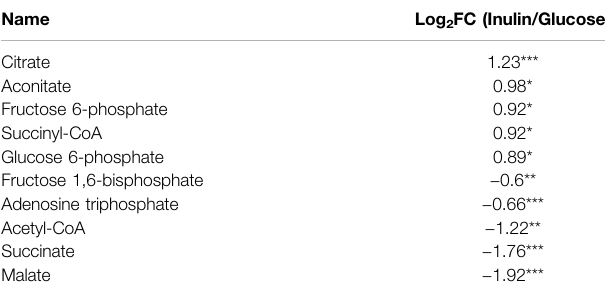
TABLE 1 | The metabolomic changes involved in the energy metabolism of F. prausnitzii according to fermentation of inulin or glucose. Data are presented with different four samples (n = 4) by LC-MS/MS. * p < 0.05, ** p < 0.01, *** p < 0.001 by two-tailed Student ’ s